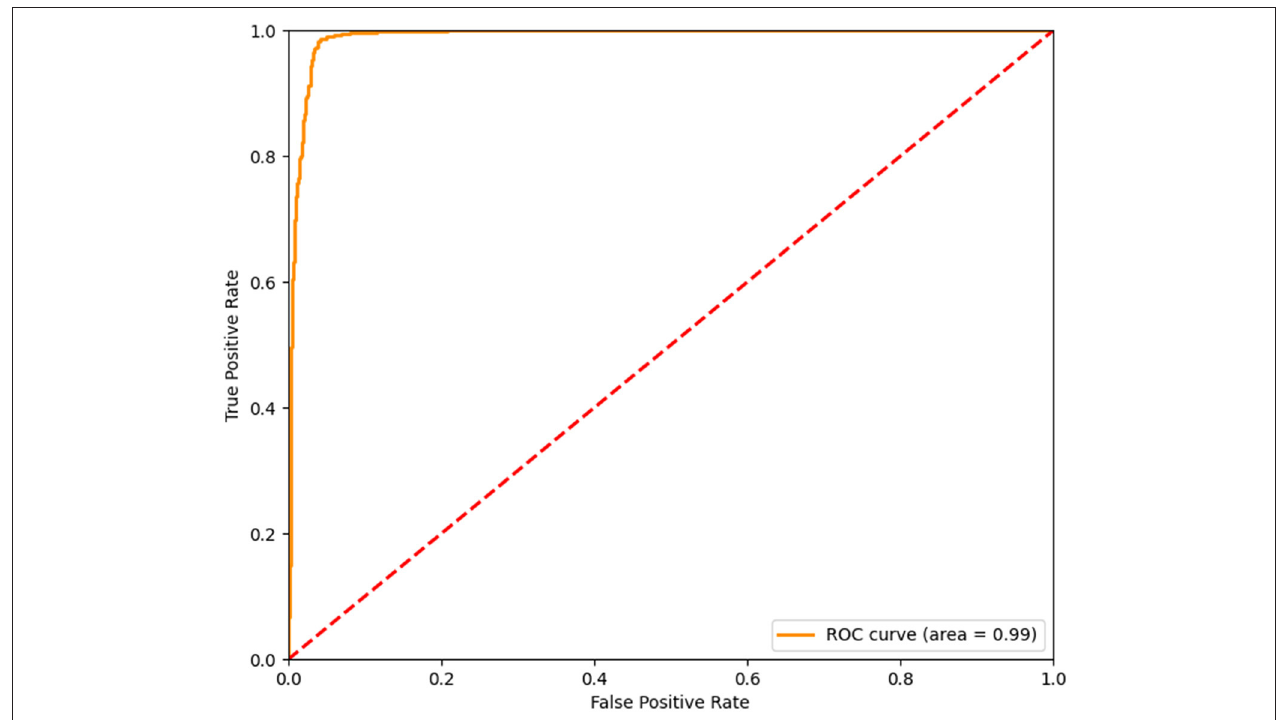
FIGURE 2 | The AUC of Model Training. The AUC of the model training based on the logical regression algorithm provided by scikit-learn was higher than 0.9. The abscissa represented the false positive rate, the ordinate represented the true positive rate. The AUC of the training model was 0.99. The closer the AUC was to 1, the better the accuracy of training model